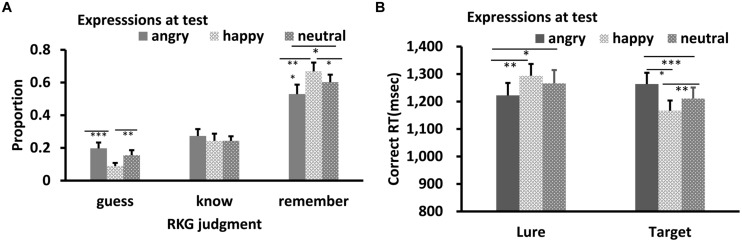
RKG judgment (A) and Correct RT (B) as a function of test expression (Experiment 2a). Error bars represent 1 SEM.∗p < 0.05; ∗∗p < 0.01; ∗∗∗p < 0.001.